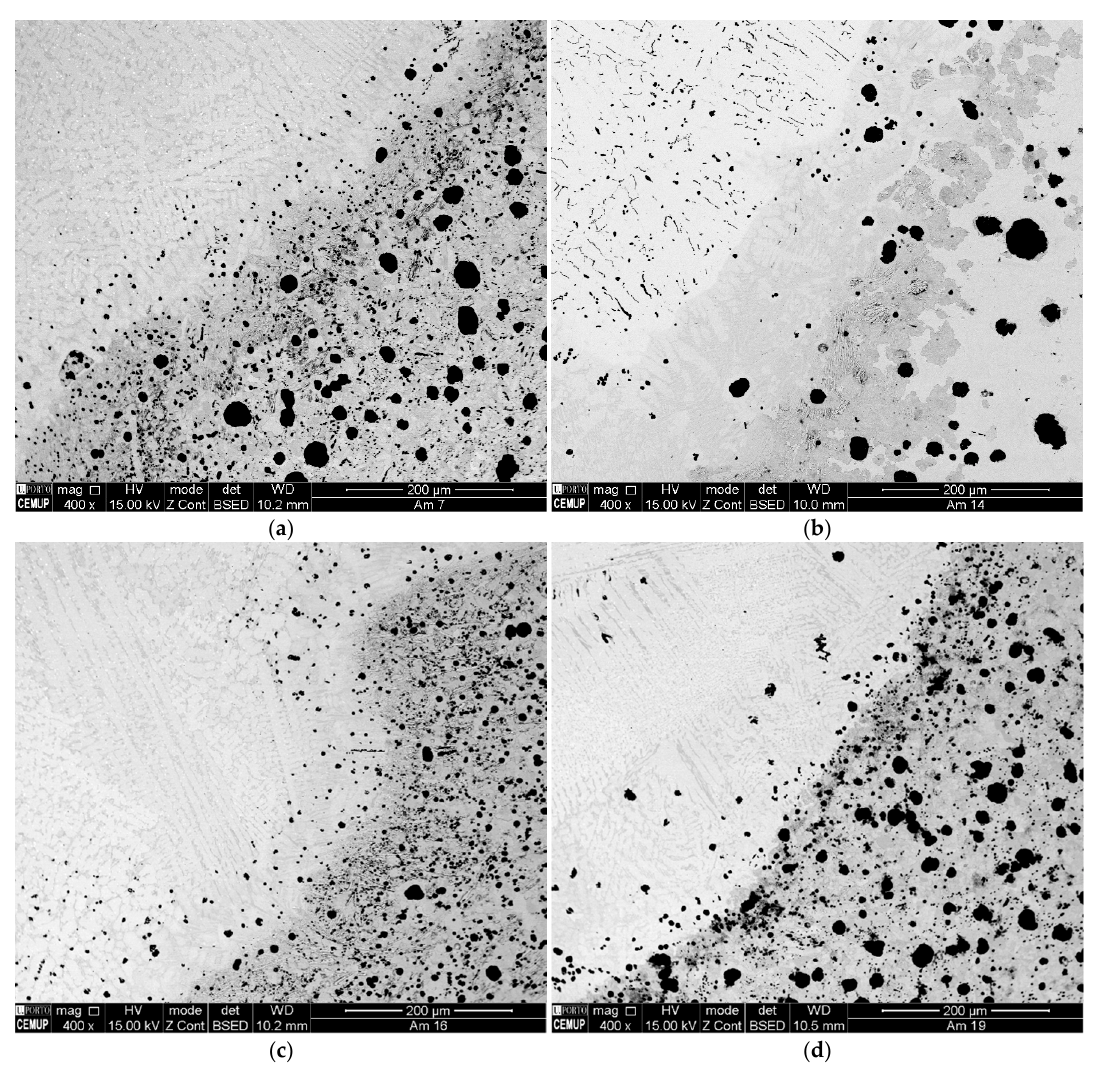
Figure 3. SEM microscopic analysis at 400× magnification with a 4% Nital etching; ( a )